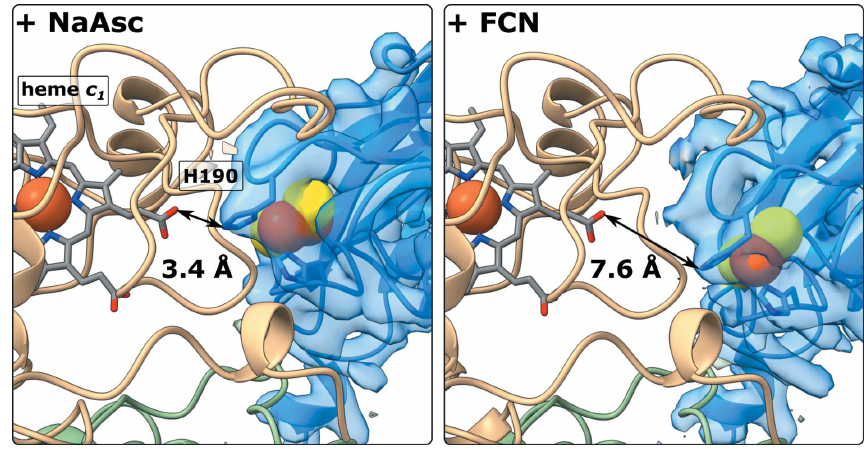
Figure 4 His190 ligating the Fe–S cluster was 3.4 and 7.6 A˚ away from the propionic acid group of heme c 1 in the c positions of the Rieske domain (blue) in ascorbate-reduced (+NaAsc) and ferricyanide-oxidized (+FCN) CIII 2 ,